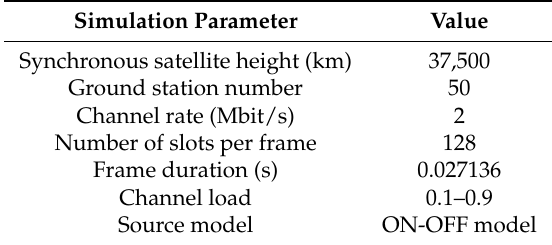
Table 3. The settings of the simulation